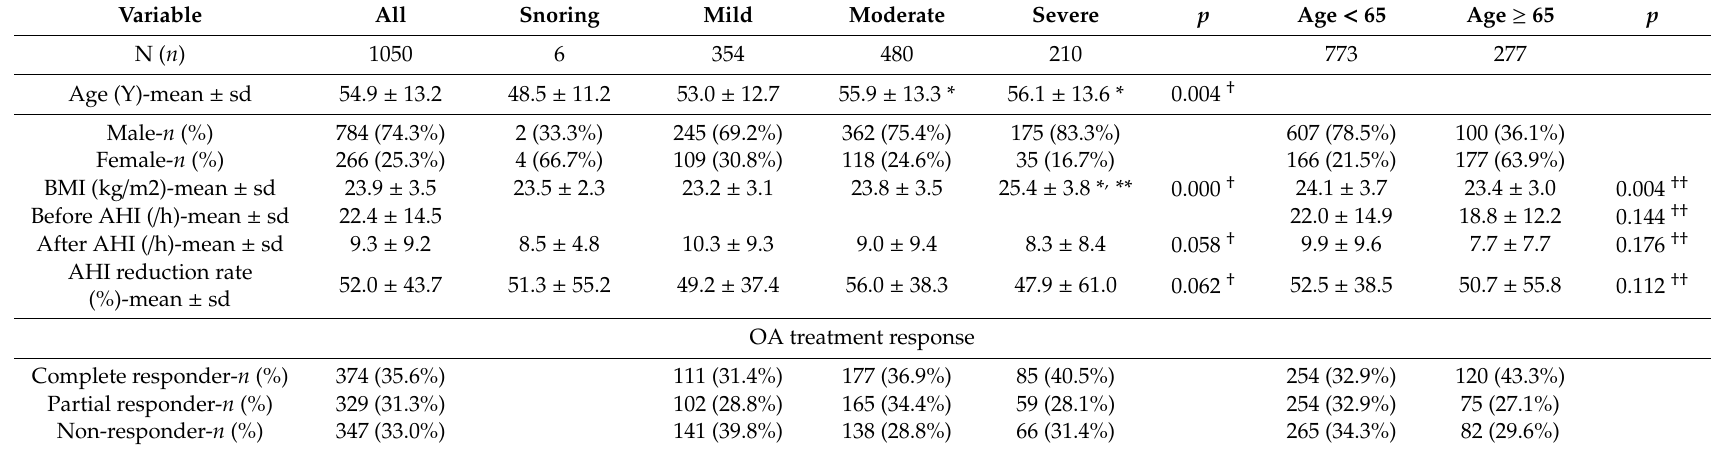
Table 3. OA e ffi